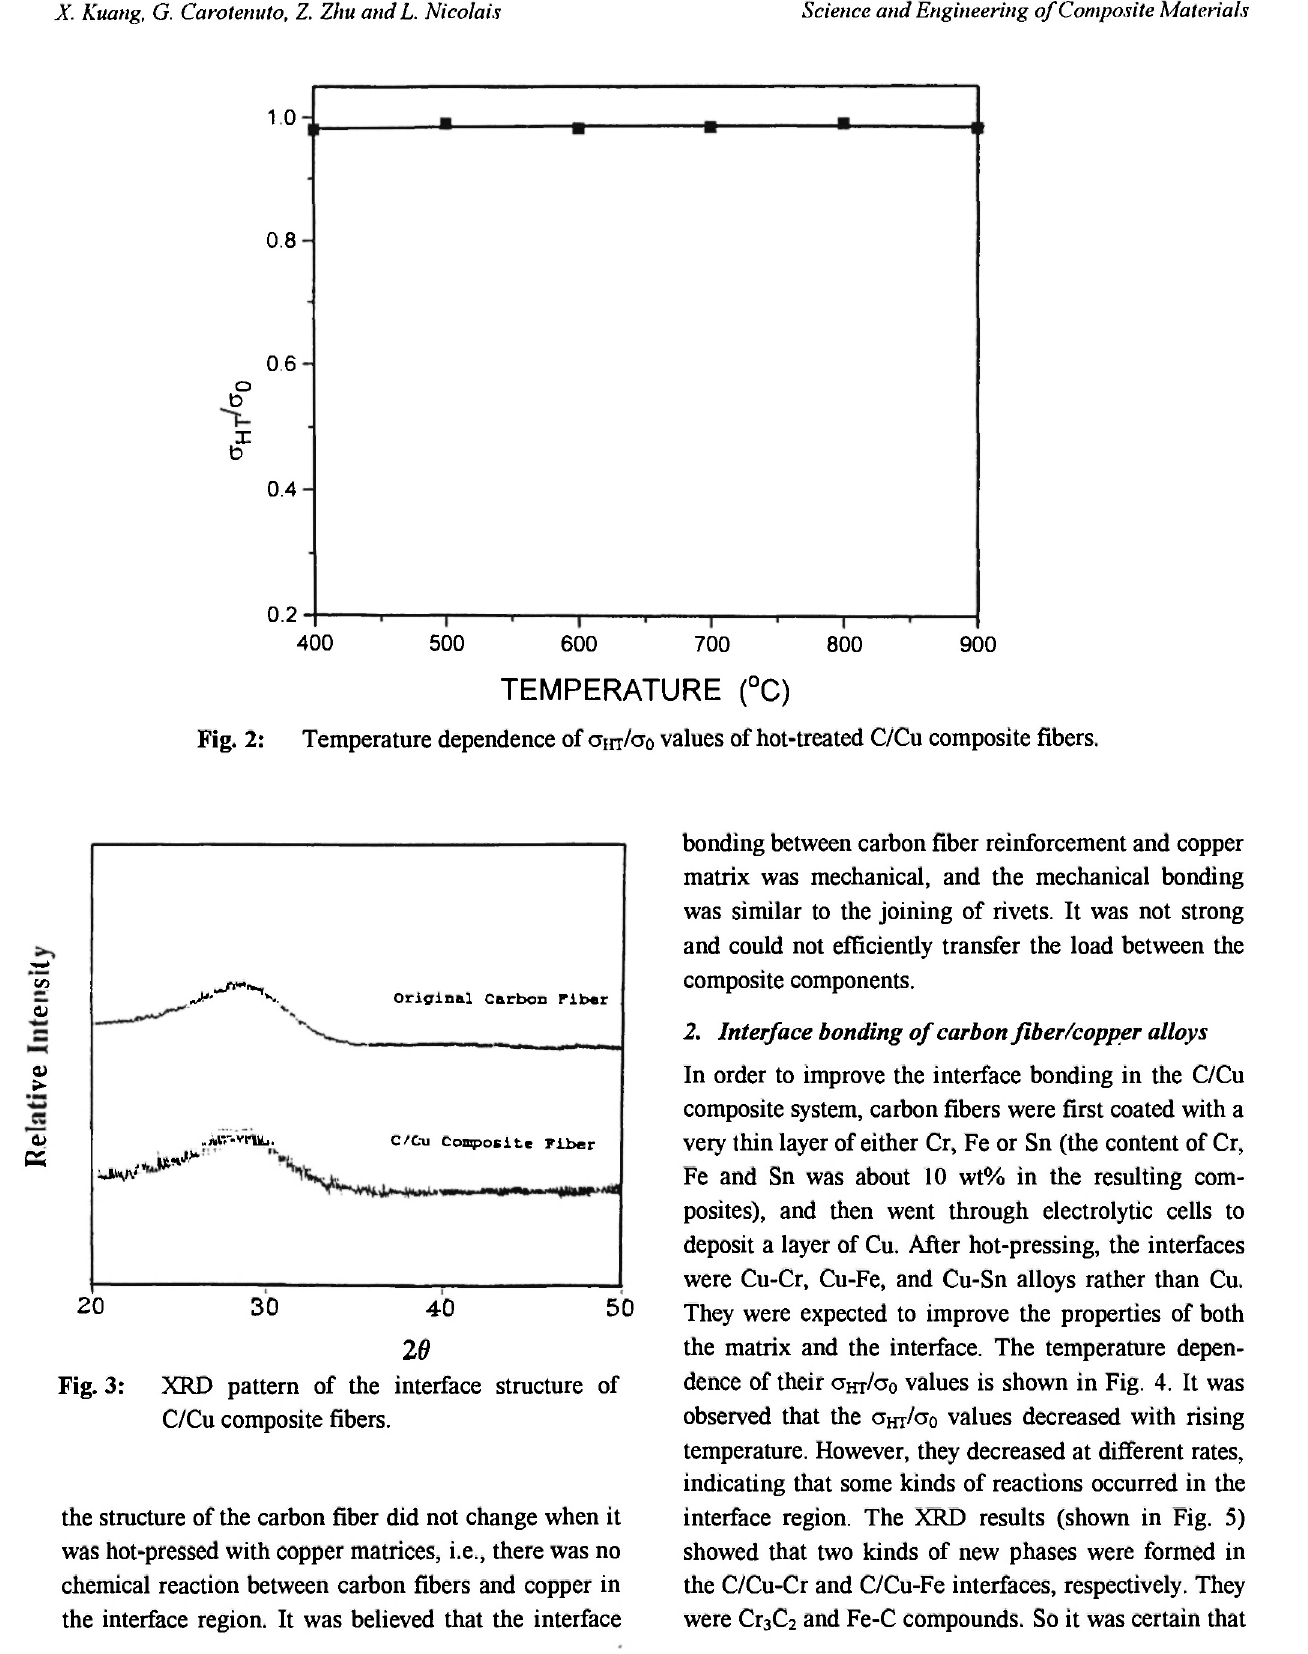
Fig. 2: Temperature dependence of σ !ΓΓ /σο values of hot-treated C/Cu composite fibers.